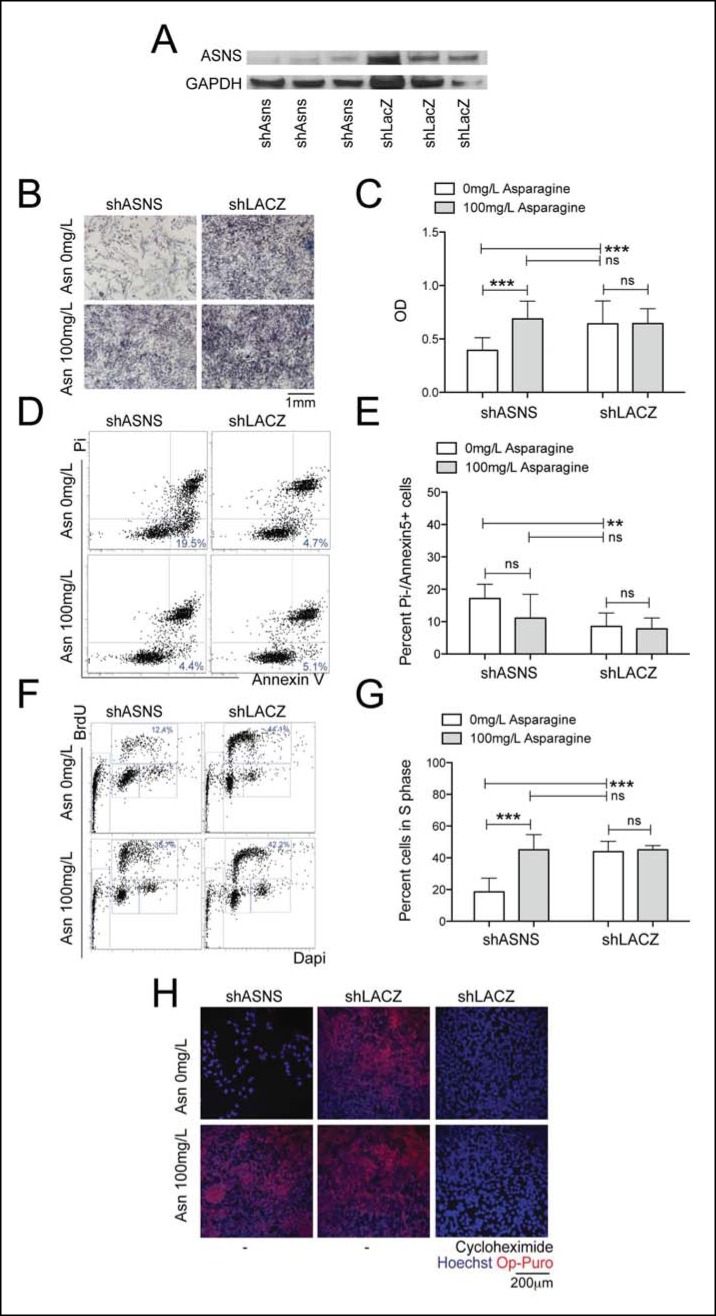
Reduced growth of human Rh30 RMS cells after ASNS silencing is associated with reduced polypeptide synthesis.(A) ShRNA-mediated silencing of ASNS in Rh30 cells was validated by Western Blot. (B–C) ASNS silencing reduced proliferation compared to shLACZ-infected control cells as measured by MTT uptake. Asparagine supplementation (100 mg/L) in the tissue culture medium reversed the anti-proliferative effects of shASNS. (D–G) ASNS silencing increased the (D–E) percentage of apoptotic (PI-/Annexin5+ ) cells and reduced the (F–G) percentage of S-phase cells , as compared to shLACZ-infected control cells. (F–G) Exogenous Asparagine supplementation reversed shASNS effects on cell cycle progression. (H) Polypeptide synthetic activity was determined by OP-puromycin staining. Absent OP-puromycin staining in Rh30 cells treated with cycloheximide (right panels) validated the experimental approach. ASNS silencing reduced polypeptide synthesis (top left panel), and polypeptide synthesis was restored in shASNS RMS cells by Asparagine supplementation (bottom left panel). (B–G) Data were evaluated for statistical significance by T-tests (ns p≥0.05, * p<0.05, ** p<0.01, *** p <0.001).